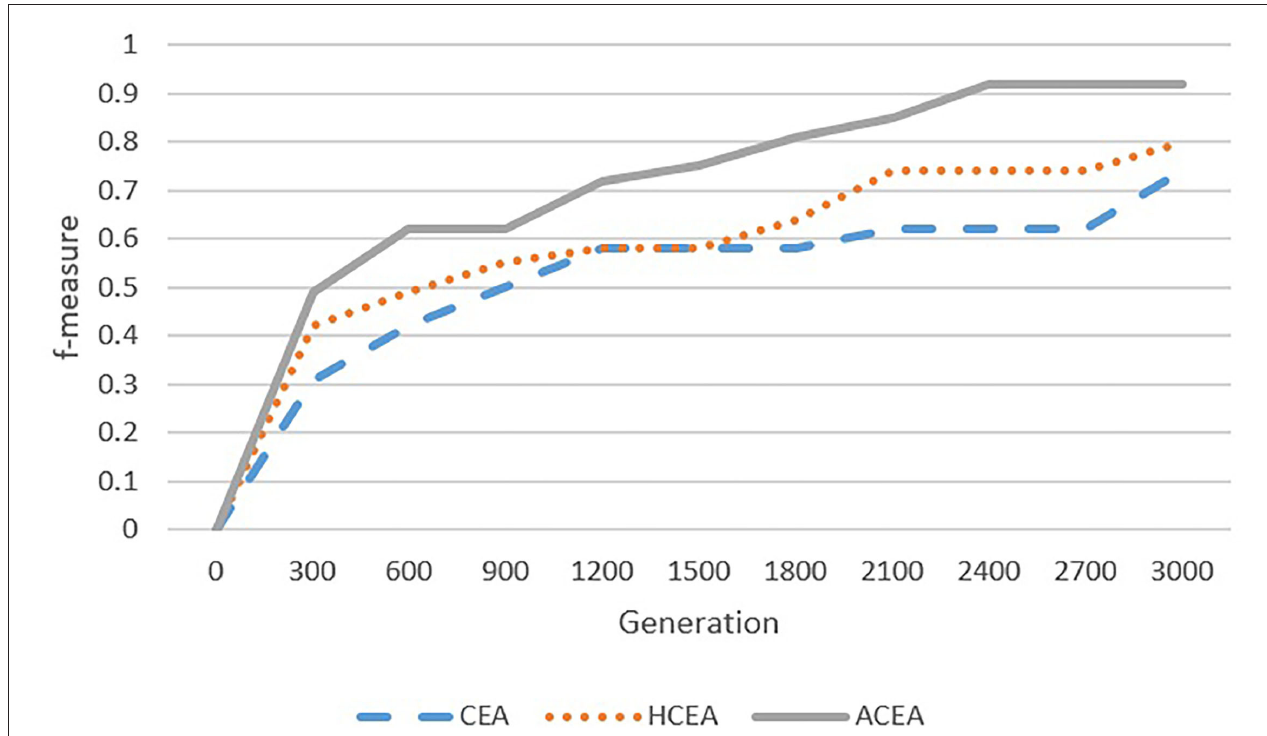
FIGURE 9 | Comparison among ACEA, CEA, and HCEA in terms of convergence graph on ANAEETHES-GEMET.